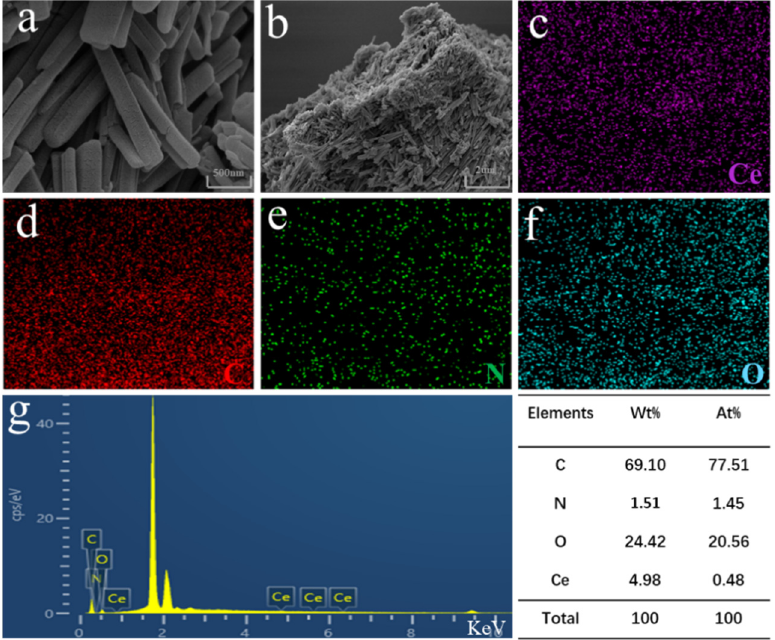
Figure 3. ( a , b ) SEM fi gures; ( c – g ) EDS mapping of Ce-H3TATAB-MOFs.